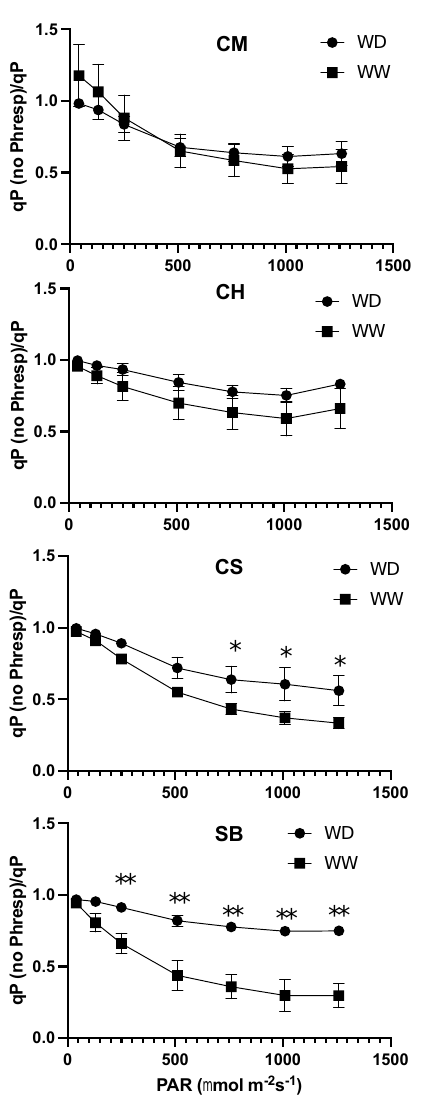
Figure 8. Relationship between qP measured under non-photorespiratory conditions and under photorespiratory conditions, at increasing light intensities in WW (squares) and WD (circles) for Carmenere (CM), Chardonnay (CH), Cabernet sauvignon (CS) and Sauvignon blanc (SB). Error bars represents SE. Single asterisk represents significant differences between treatments for each variety p ≤ 0.05. Double asterisk represents significant differences between treatments for each variety p ≤